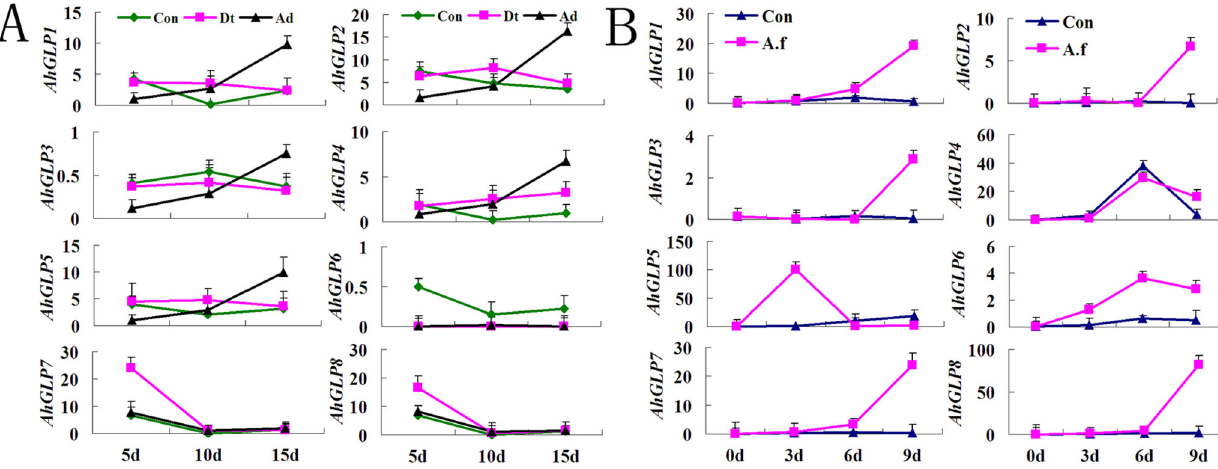
Figure 3. Expression of AhGLPs in response to A.flavus infection in pre - and post- harvested peanut seeds. A: Con: control; Dt: drought stress; Ad: A. flavus infection under drought stress condition; B: Changes of the expression of AhGLP family genes in damp-dry peanut seed with 20%